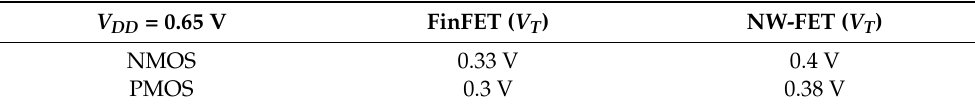
Table 2. V T data of each